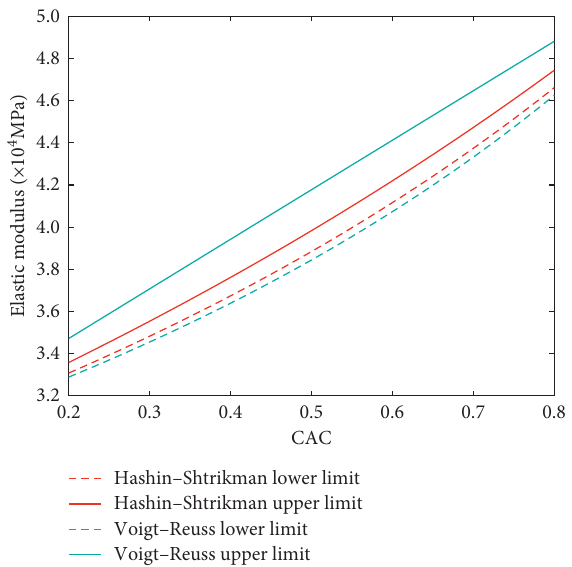
Figure 4: Effect of the CAC on analytical elastic modulus